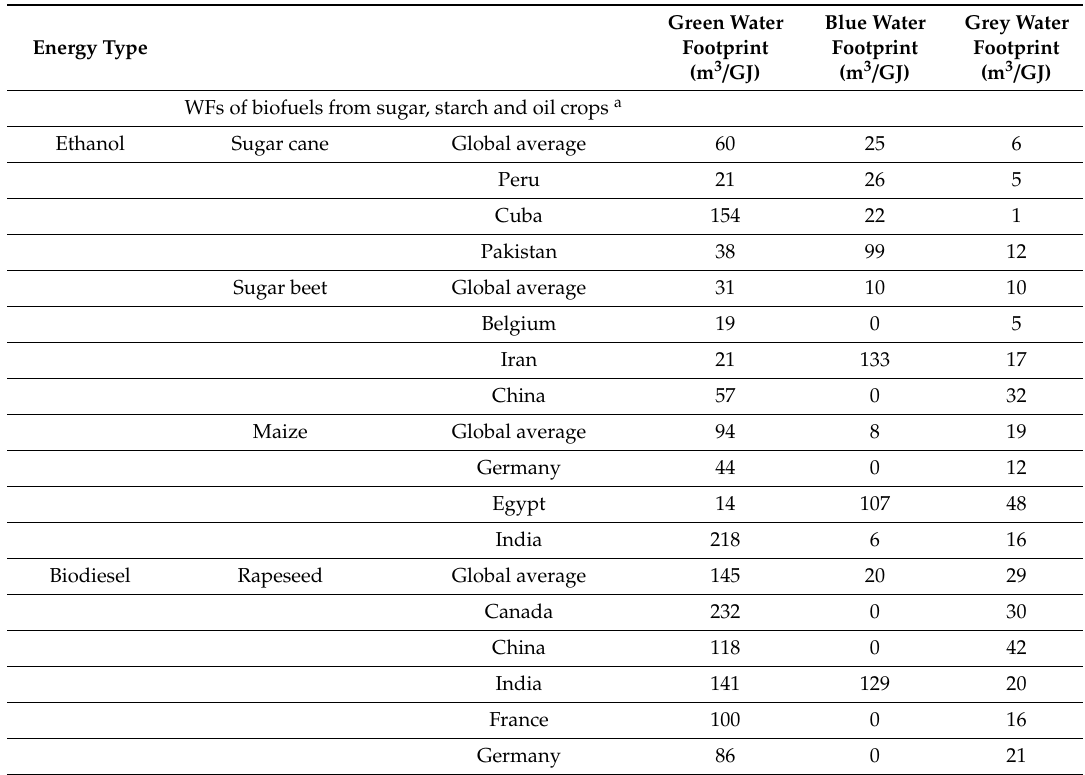
Table A1. Overview of green, blue and grey water footprints for di ff erent energy types (m 3 /